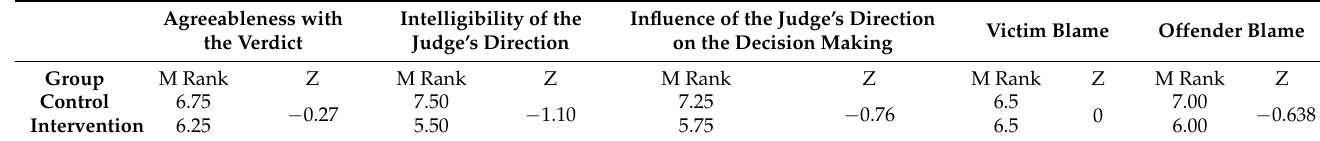
Table 1. Mann-Whitney U results with respect to groups.